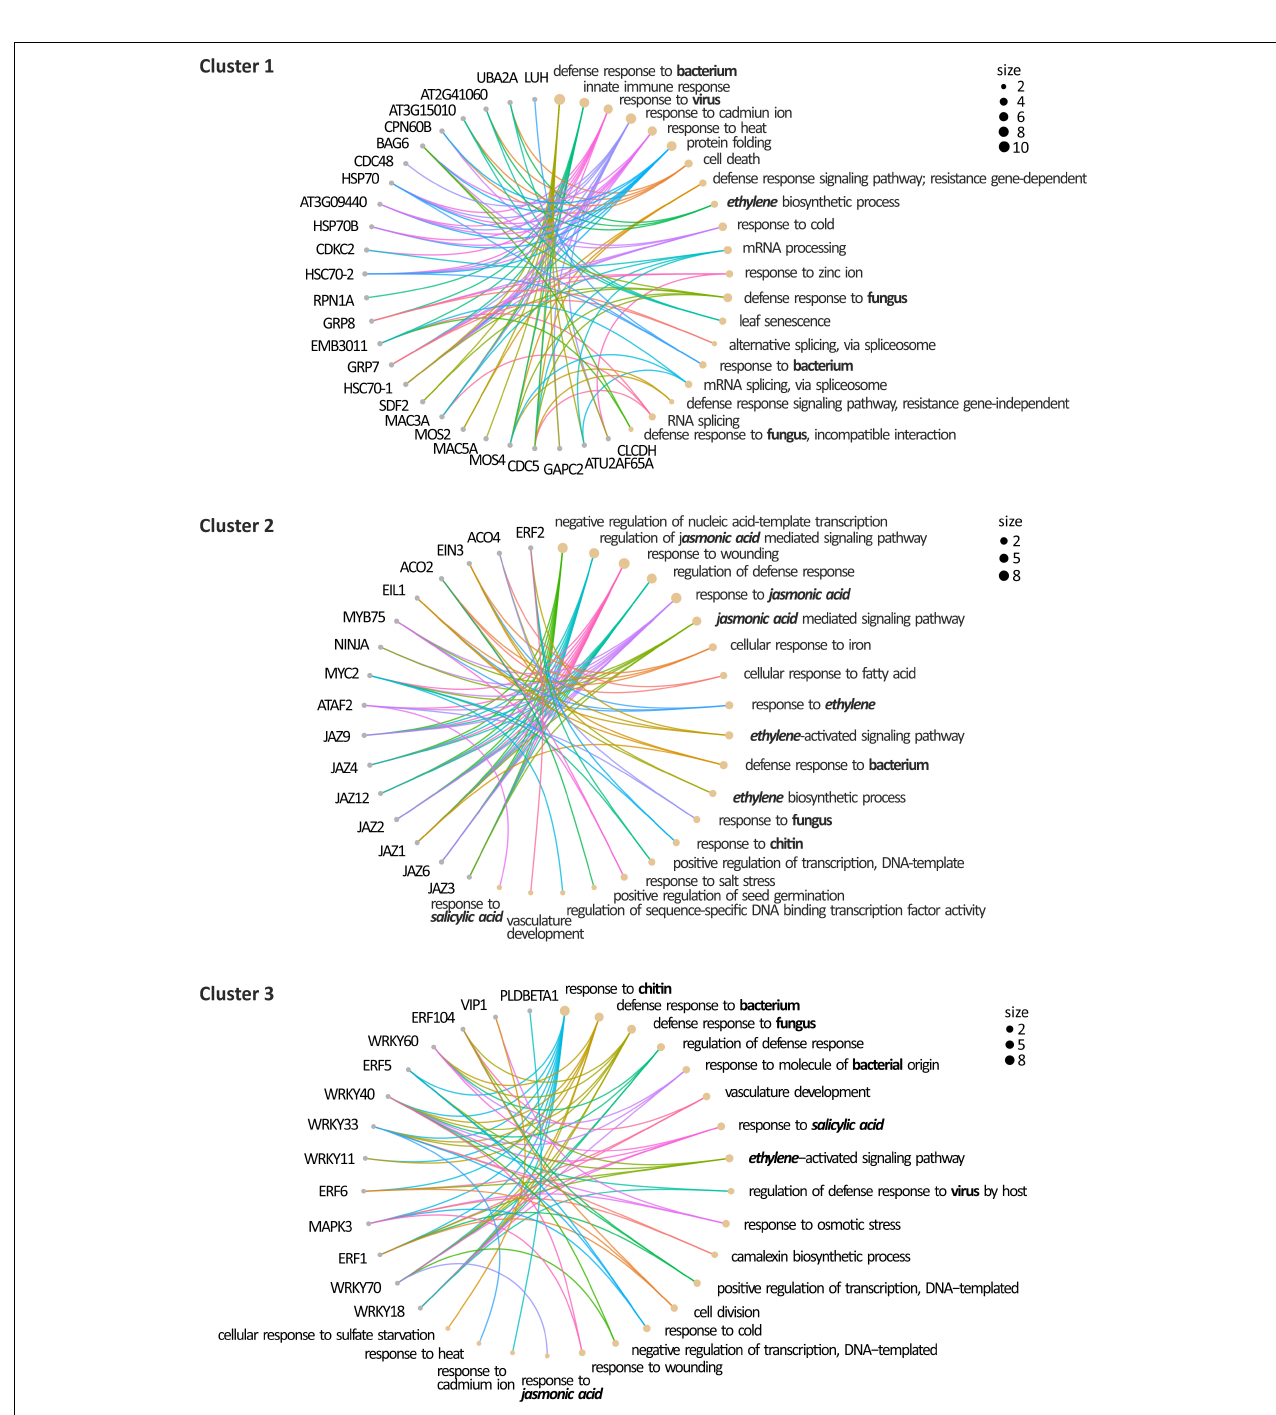
FIGURE 4 | Gene Ontology Analysis of the defense SUMOylome. Gene ontology of the defense SUMOylome interactions: The proteins included in the clusters identified in Figure 3 were submitted to the DAVID Gene Ontology Enrichment Analysis tool (https://david.ncifcrf.gov/) using default parameters. The retrieve gene ontology terms are visualized on CirGO plots. The size represents the scale of the number of the analyzed genes that belong to the ontology. Functional categories related to defense hormones and responses to pathogens are in bold.